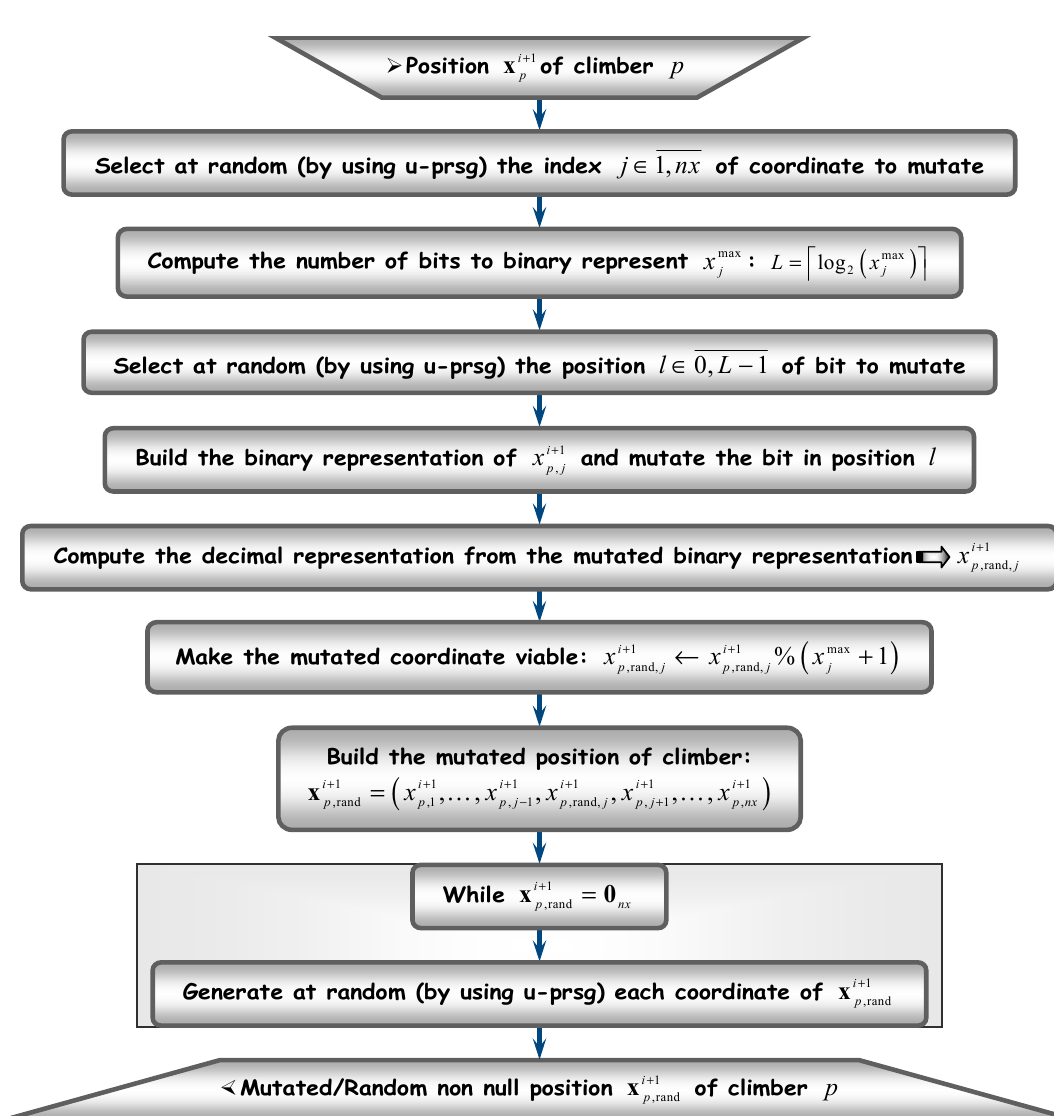
Figure 4. Mutating a climber position.